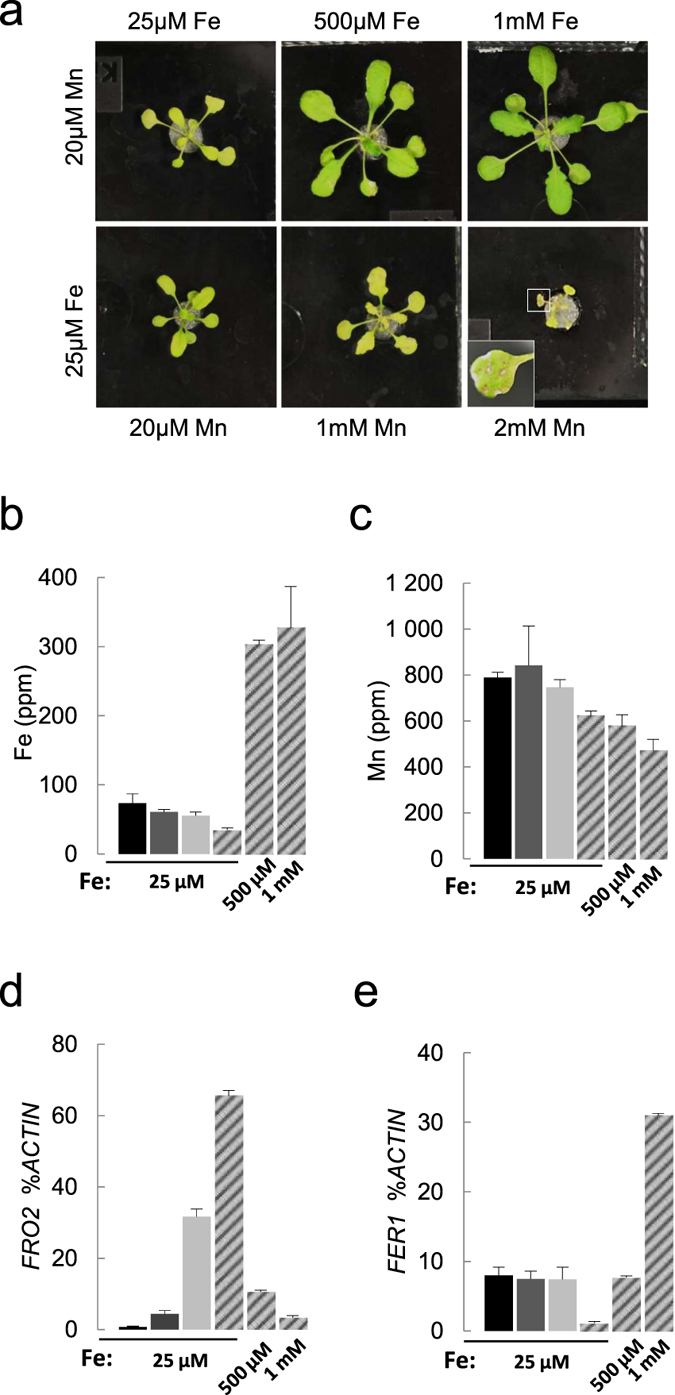
Fe, but not Mn, rescues the phenotype of nramp1-1 irt1-1.(a) Picture of 24 day-old nramp1-1 irt1-1 mutants grown in hydroponic medium containing 20 μM Mn and a range of Fe supply (25 μM, 500 μM Fe, 1 mM Fe, top lane) or 25 μM Fe and a range of Mn supply (20 μM, 1 mM Mn, 2 mM Mn, bottom lane). The inset in the bottom right picture shows a close up of the leaf necrotic lesions. (b) and (c) respectively Fe and Mn concentration in shoots of plants grown as in (a). Wild type plants (black), nramp1-1 (dark grey), irt1-1 (light grey) and nramp1-1 irt1-1 mutants (stripes). Means ± sd. (n = 3 replicates of 8 to 12 plants each). (d) and (e) Respectively FRO2 and FER1 expression in roots of the plants shown in (b) and (c). Transcripts levels were measured by qRT-PCR relative to those of the reference gene ACTIN ± s.d. (n = 3 technical replicates).